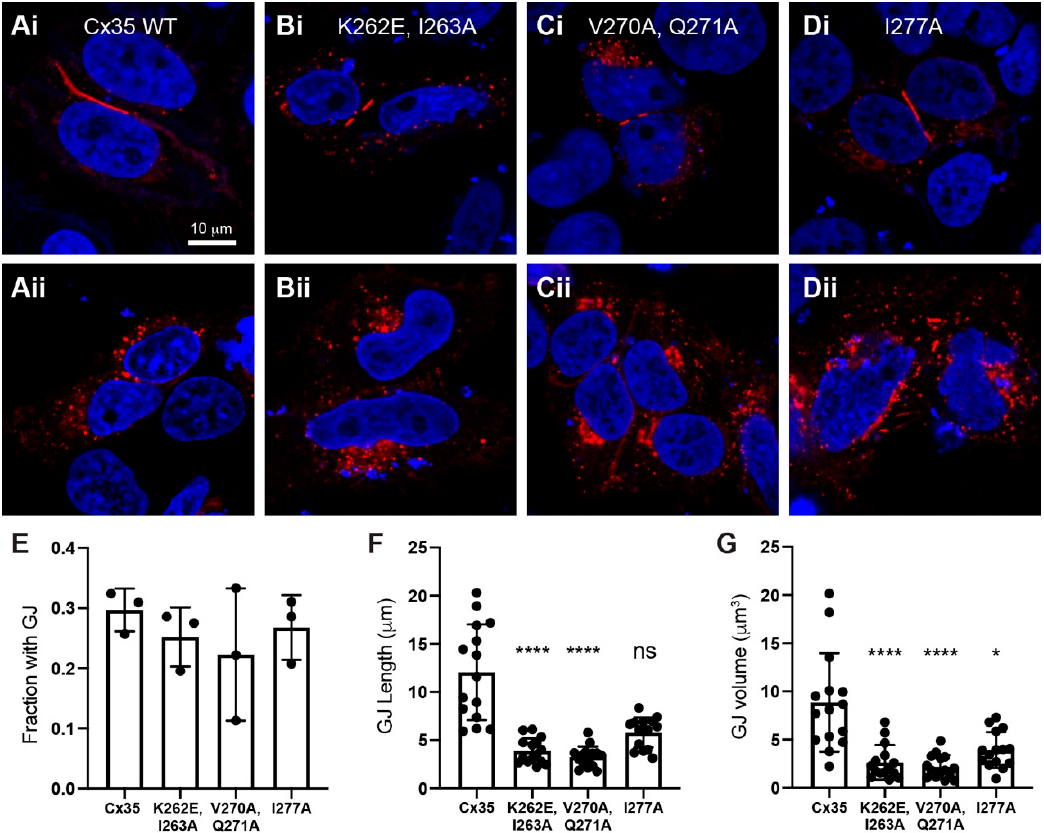
Figure 7. Trafficking and gap junction formation of Cx35 calmodulin binding site mutants. ( A – D ) Immunofluorescence labeling of Cx35 (red), with DAPI-labeled nuclei (blue). Two examples each of cells transiently transfected with wild type Cx35 ( A ), K262E, I263A mutant that exhibits no calmodulin binding ( B ), V270A, Q271A mutant that exhibits nearly normal calmodulin binding ( C ), and I277A mutant that exhibits mildly reduced calmodulin binding ( D ). Scale bar in Ai applies to ( A – D ). ( E ) Fraction of Cx35-expressing cell pairs with visible gap junctions; n = 3 experiments. ( F ) Quantitation of gap junction length, and G gap junction volume; n = 15 gap junctions from 3 experiments; Kruskal–Wallis test: **** p < 0.0001, * p < 0.05, ns = not significant vs. Cx35 wild type. Bars in ( E – G ) are mean ± SD.